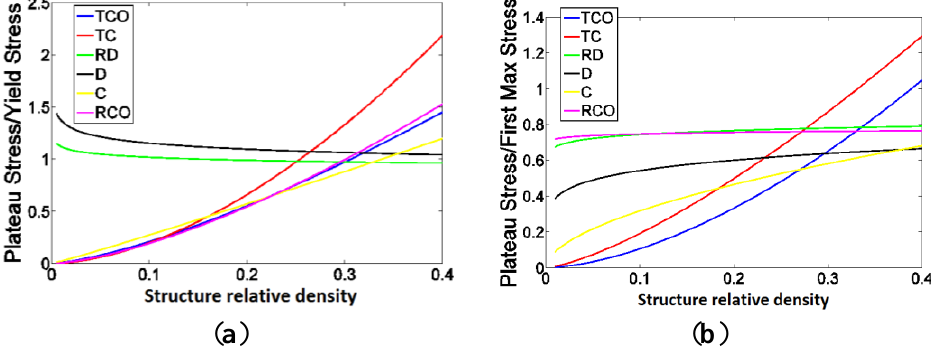
Figure 15. ( a ) The ratio of plateau stress to yield stress as well as ( b ) the ratio of plateau stress to first maximum stress for different types of unit cells. In these figures, the power laws fitted to the experimental data points, and not the experimental data points themselves, are compared with each